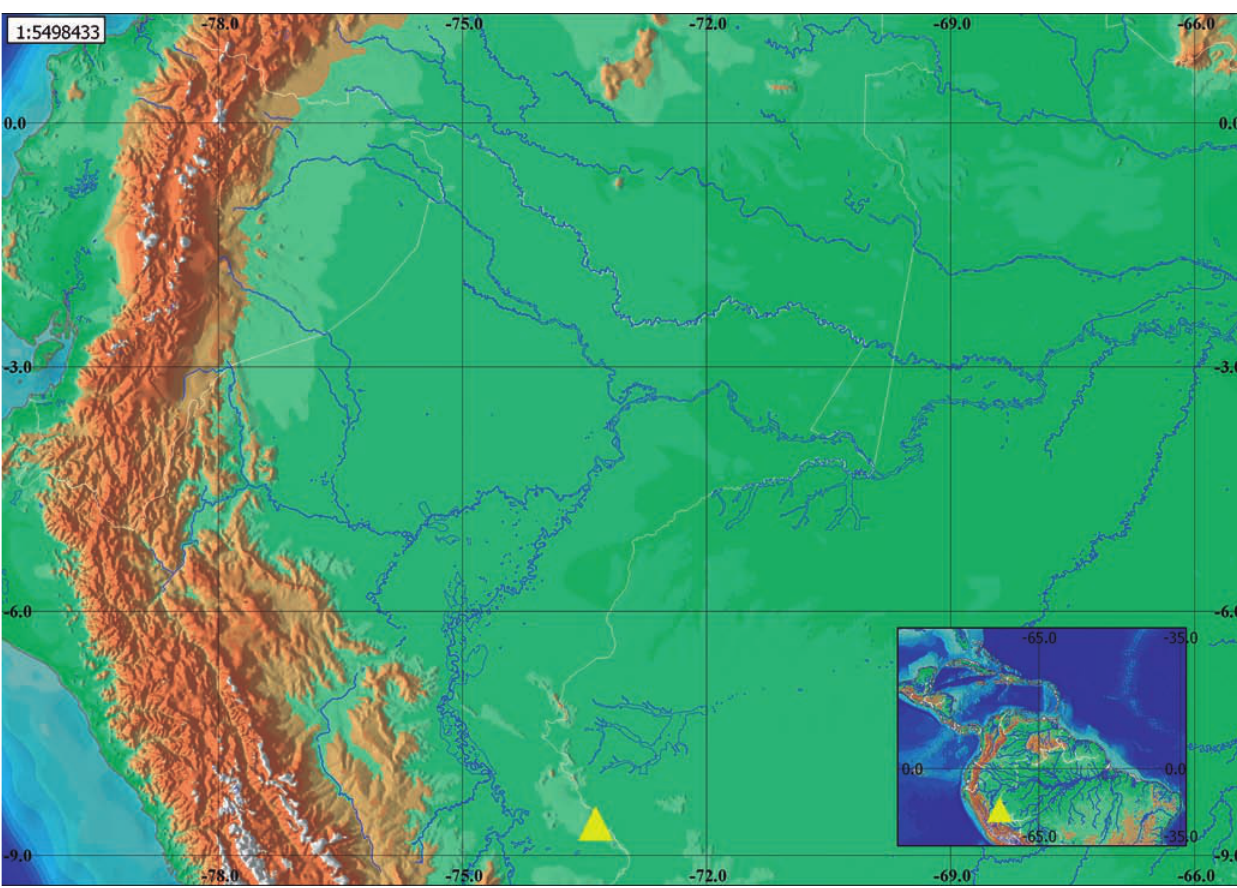
Fig. 5. Geographic distribution of Chrysobrycon yoliae (yellow